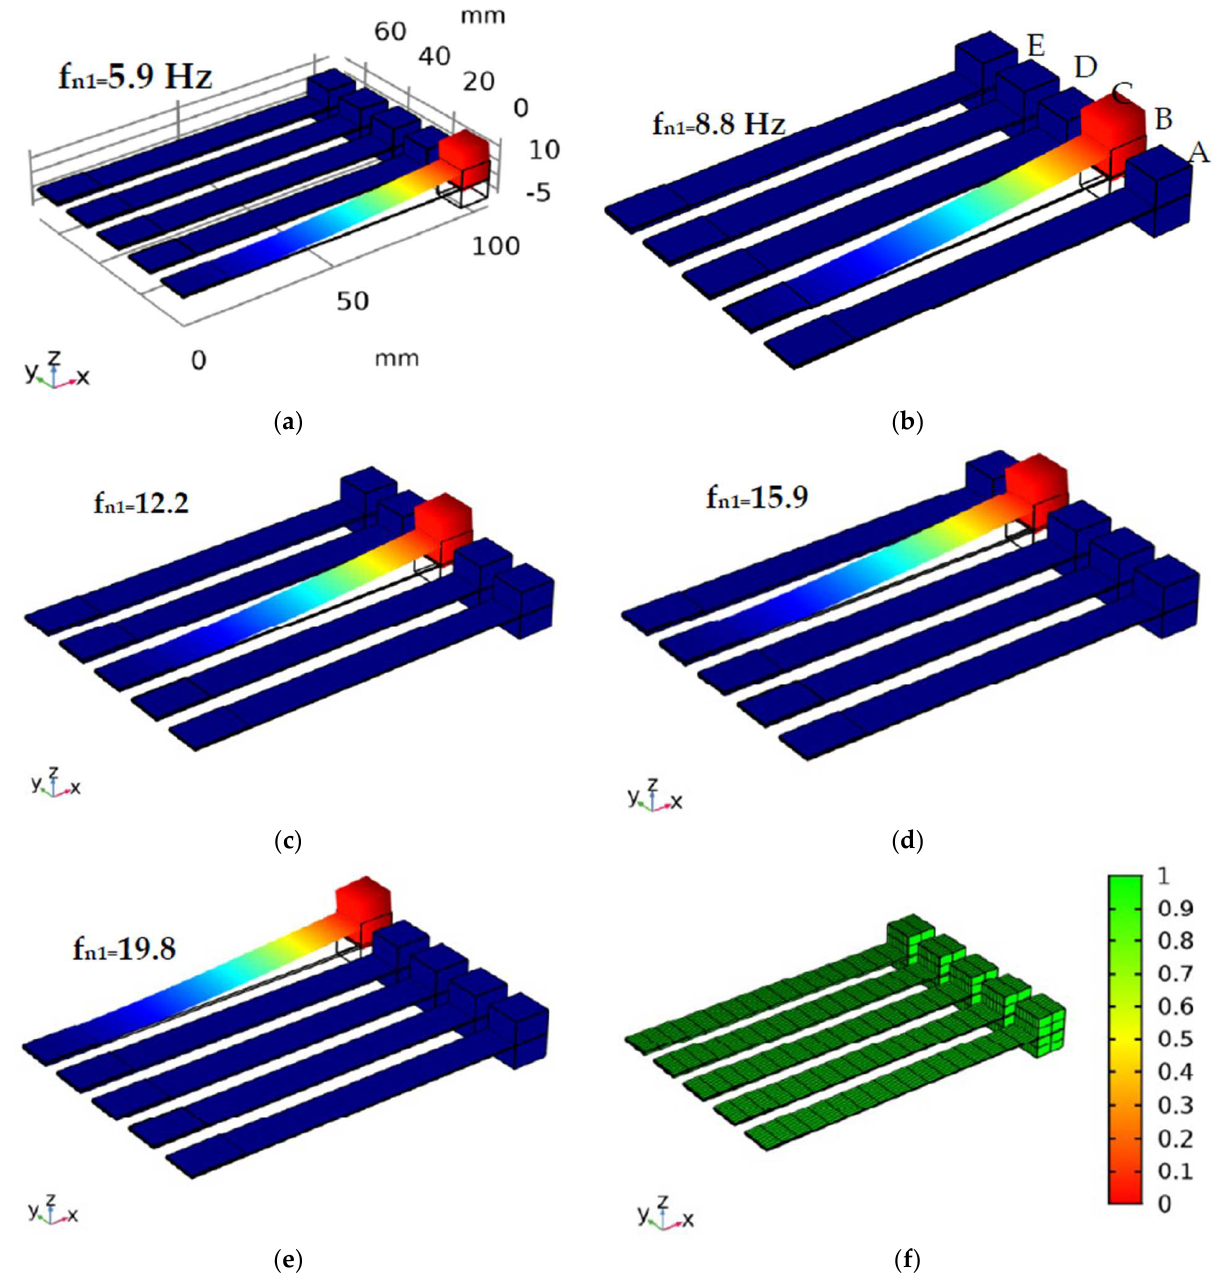
Figure 6. The natural frequencies of the second array model. ( a ) natural frequency of beam A, ( b ) natural frequency of beam B, ( c ) natural frequency of beam C, ( d ) natural frequency of beam D, ( e ) natural frequency of beam E, and ( f ) mesh accuracy of array harvester.